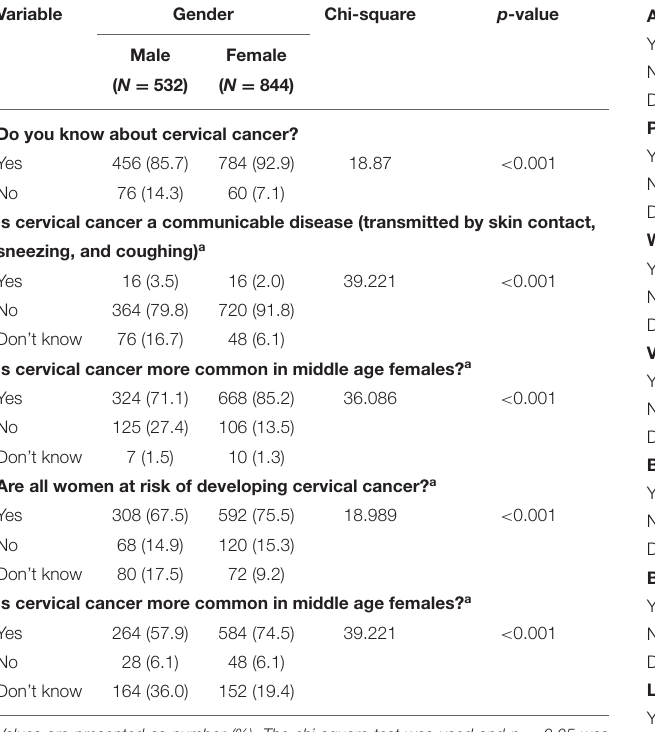
TABLE 2 | Knowledge on cervical cancer epidemiology.